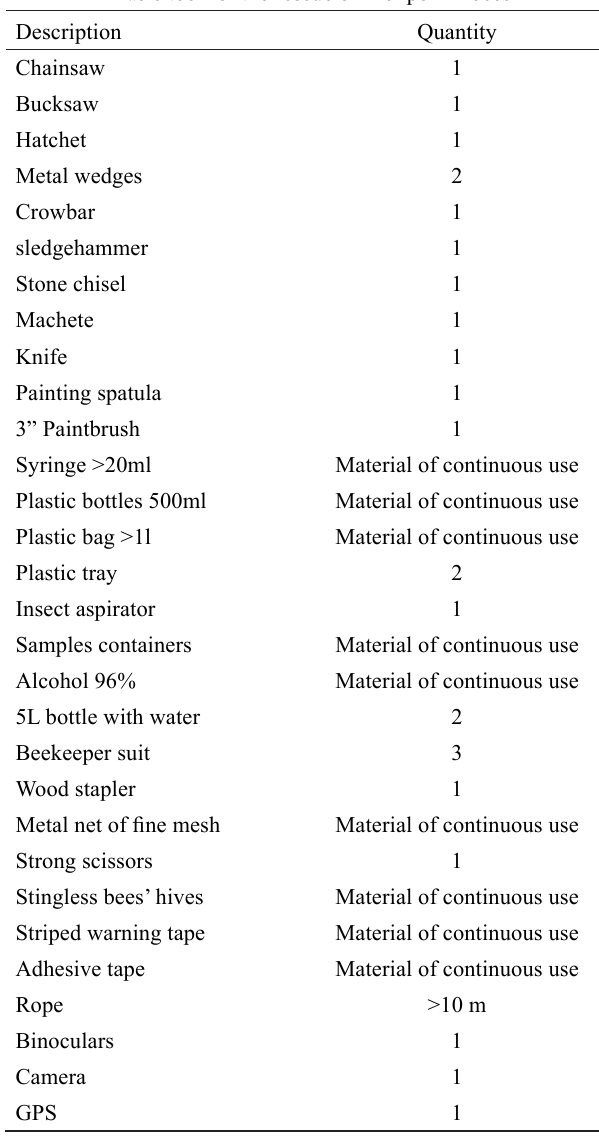
Table 1. List of basic material for one stingless bees rescue team (three